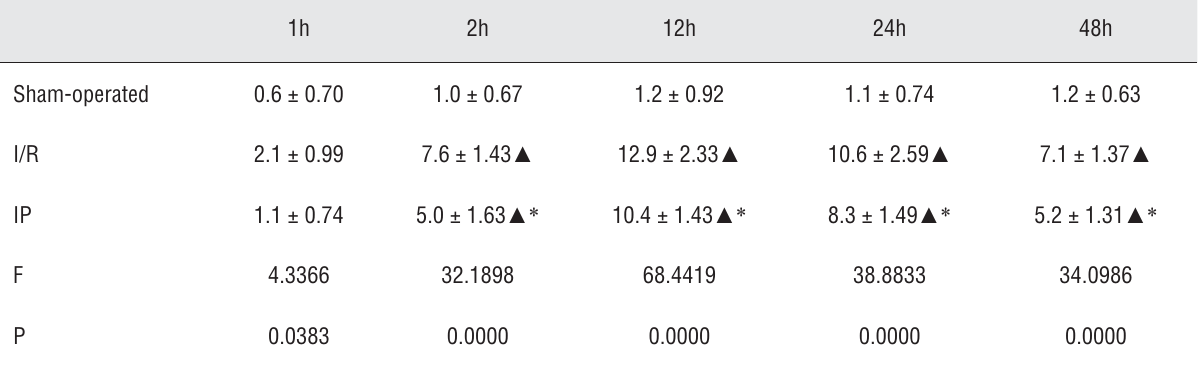
Table 1 - Effects of ischemic preconditioning on the expression of ICAM-1 in rat kidney (positive cell number/HP). 1h 2h 12h